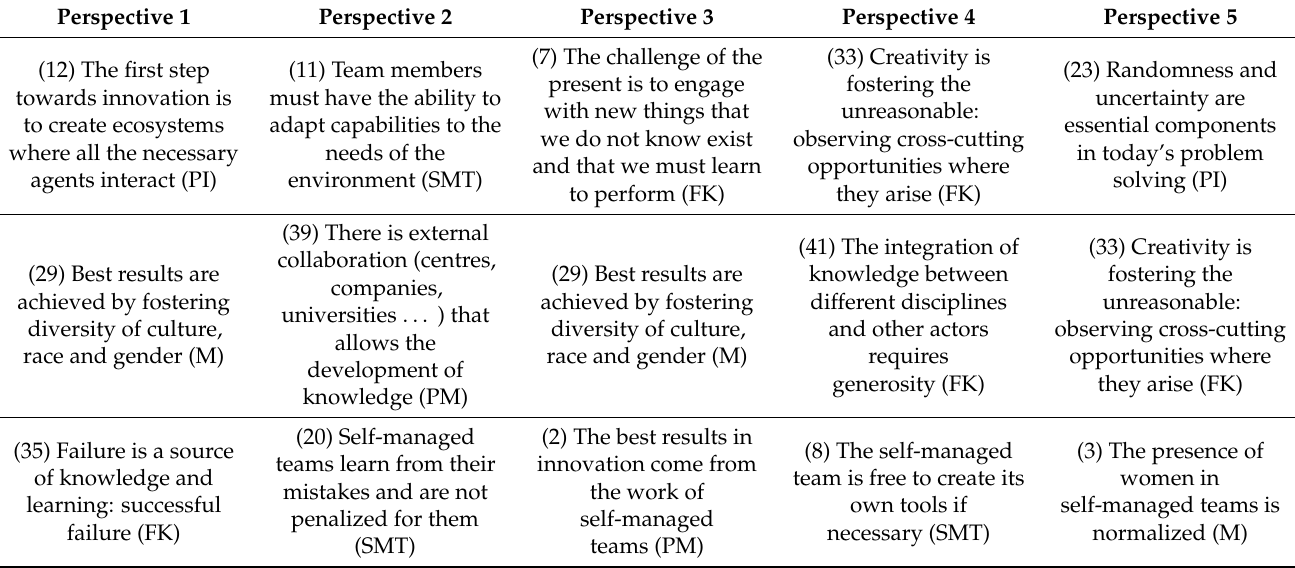
Table A1. Top-ranked statements per